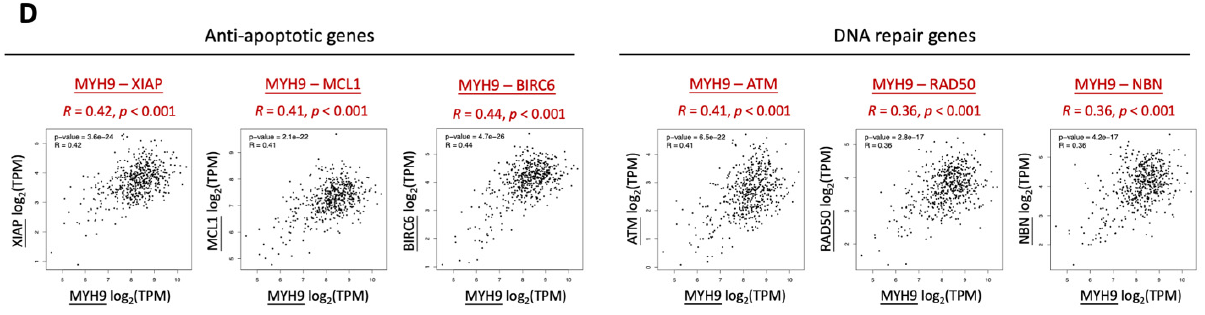
Figure 2. MYH9 contributed to radioresistance in cancer cells. ( A , B ) Transfection of MYH9-shRNA increased radiosensitivity in OECM-1 ( A ) and Detroit 562 ( B ) cells, as determined by clonogenic survival assay. ( C ) Significant increases of anti-apoptotic and DNA repair-associated gene expressions in the tumor samples compared to normal samples. The gene expression data, including XIAP, MCL1, BCL2L1, ATM, RAD50, and NBN, were retrieved from the TCGA-HNSC dataset. ( D ) Correlative expressions between MYH9 and anti-apoptotic and DNA repair associated molecules XIAP, MCL1, BCL2L1, ATM, RAD50, and NBN, in the HNC tumor samples. The gene expression data were retrieved from the TCGA-HNSC dataset. All the experiments were performed at least three times independently, and a typical result was shown. The error bars shown in the relevant figures indicated the standard deviation of the quantification results in all experiments. (*: p < 0.05, **: p < 0.01, t ‐ test).